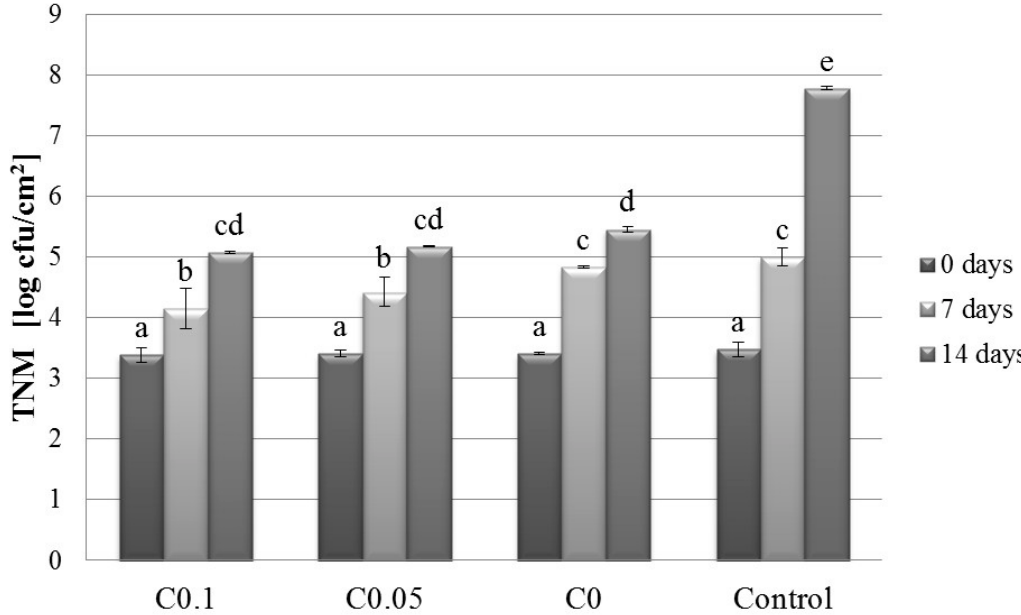
Figure 1. Effect of cellulase concentration and storage time on the total number of microorganisms in pork meat. Results are expressed as the mean ± standard error. Values with different letters (a–e) within the same column differ significantly ( p < 0.05). Control–uncoated meat; C0–0% cellulase; C0.05–0.05% cellulase; C0.1–0.1% cellulase.